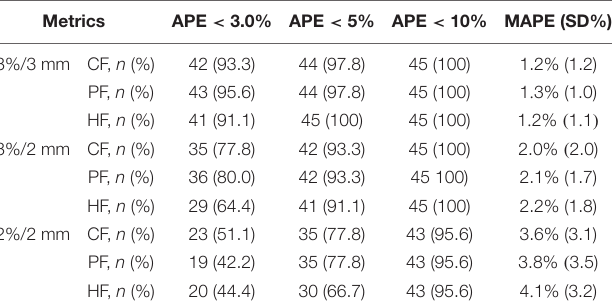
TABLE 3 | The summary average prediction error in the testing cohort by using the three feature modalities at different gamma criteria.